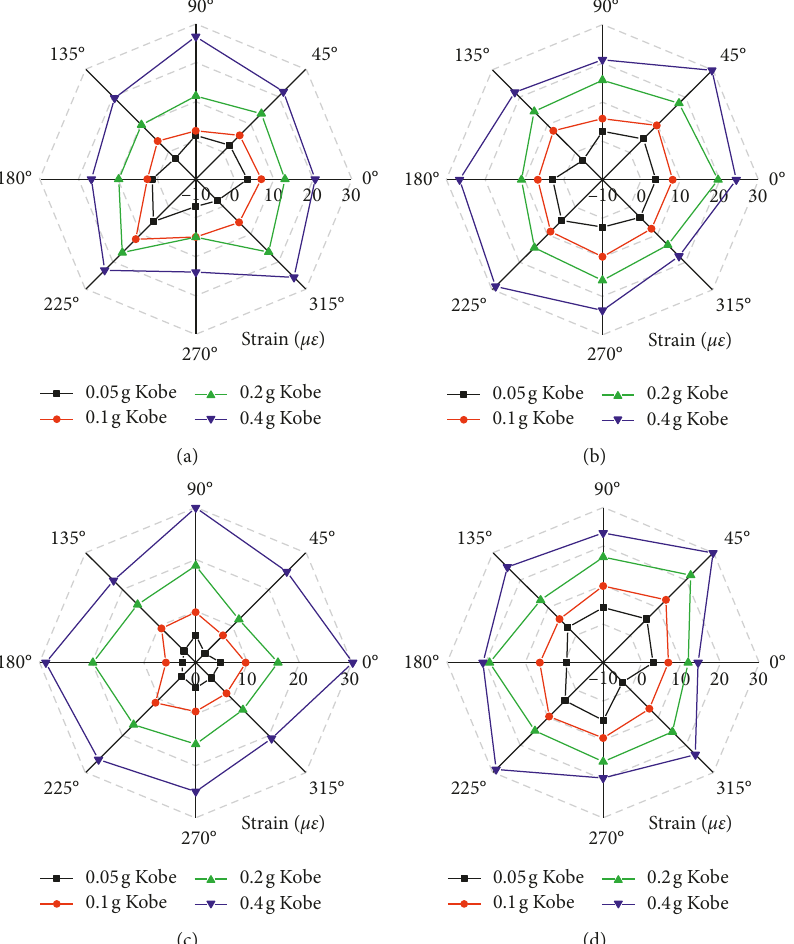
Figure 19: Maximum strains of the model tunnel with SAL for different peak acceleration levels. (a) Inner surface of the tunnel longitudinal. (b) Inner surface of the tunnel hoop. (c) Outer surface of the tunnel longitudinal. (d) Outer surface of the tunnel hoop. Table 7: The maximum strain of the model tunnel with SAL and without. Maximum strain ( με ) Model tunnel Model tunnel with SAL Longitudinal